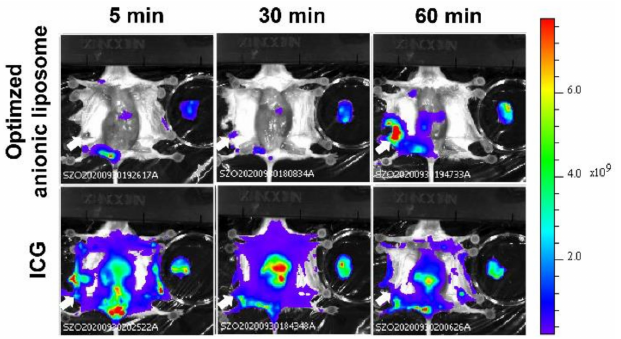
Figure 5. Comparison of SLN selectivity between liposomal imaging and ICG. Mice were imaged 5, 30 and 60 min after the intratumoral injection of each imaging agents. Independent two individuals were observed in each